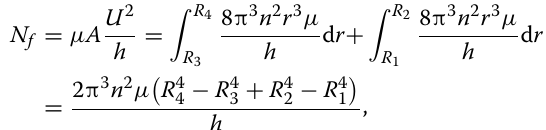
Figure 3 Change of leakage flow with